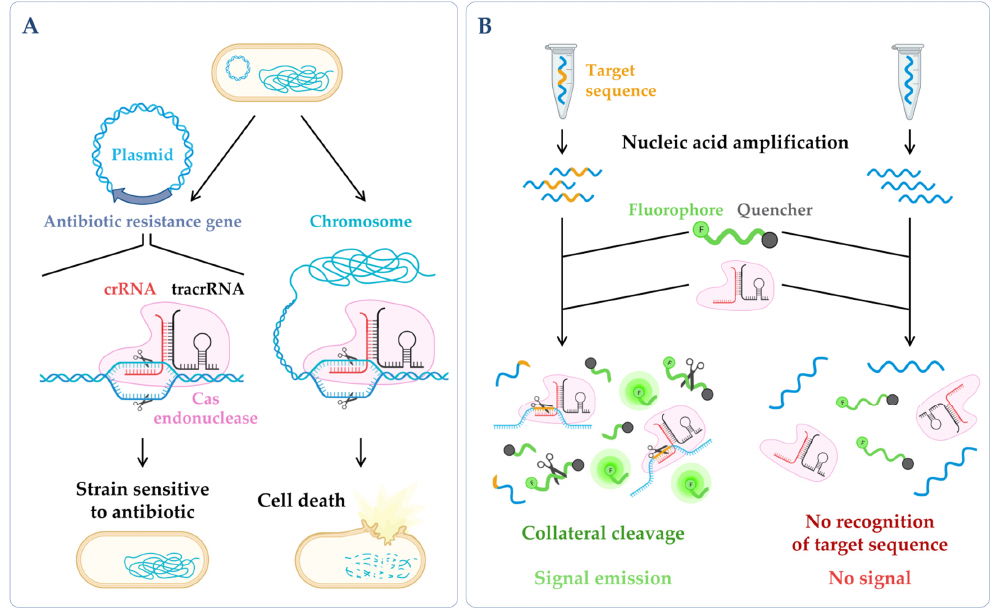
Figure 3. CRISPR technologies. ( A ) CRISPR-based antimicrobials. The system has been successfully tested through the directed degradation of the antibiotic resistance gene located in a plasmid (left side) leading to the recovery of the bacterial antibiotic sensitivity or the directed degradation of chromosomal genes, and consequently, cell death (bactericidal) [186]. ( B) CRISPR-based diagnostics. When CRISPR effector proteins (Cas) recognize the specific target site, their collateral cleavage capability is triggered (this indiscriminate nucleic acid cleavage only happens when the crRNA finds its match). The addition of a reporter, that only releases the signal upon cleavage, enables the emission of a signal that can be easily detected [187]. Figure created using BioRender.com (accessed on 11 th of November 2022).